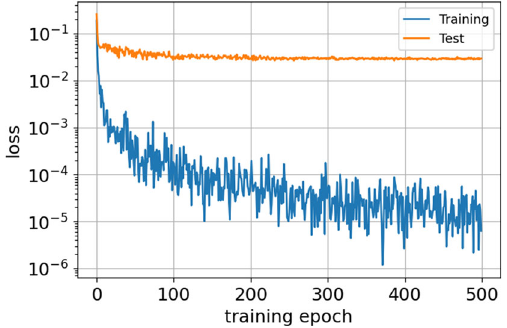
Fig. 3 The loss of training and test data